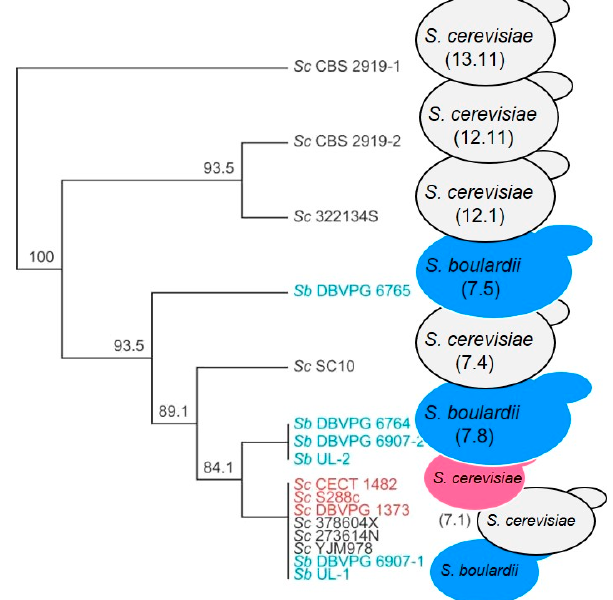
Figure 5. Boot-strapped neighbor-joining cladogram of rDNA ITS1 sequences. Bootstrap values (%) are indicated at each node in the tree. S. boulardii (Sb); S. cerevisiae (Sc). Clinical strains are in black, probiotic strains in blue, and non-medical strains are indicated in red colour. Adapted from MacKenzie et al. [44].